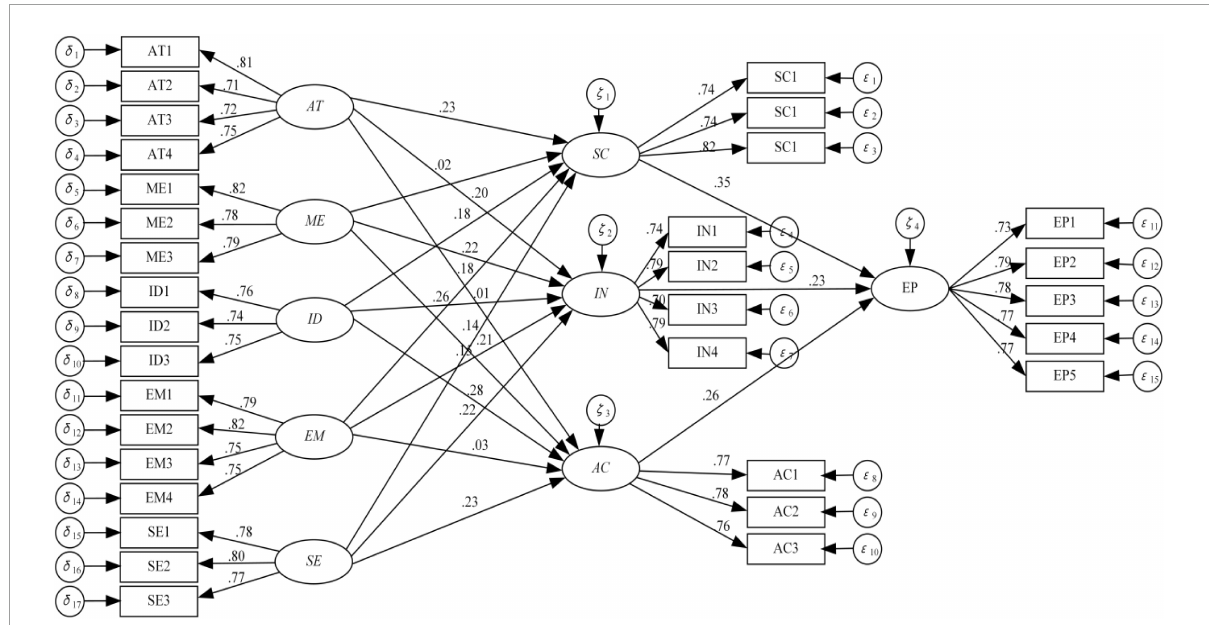
FIGURE2 The fitting results based on structural equation modeling (SEM).